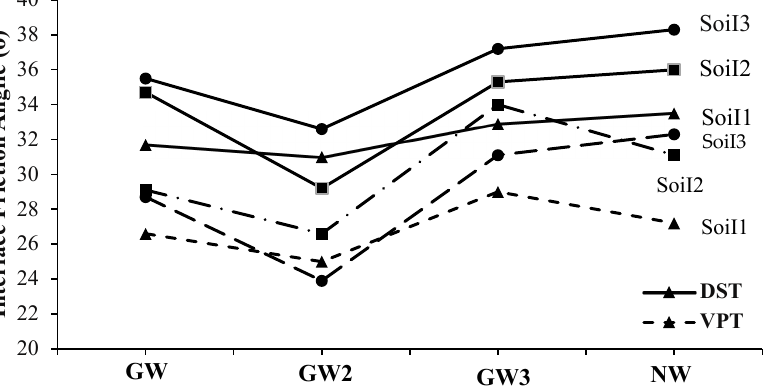
Figure 8. Comparison of interface friction angles obtained from modified direct shear tests and vertical pullout tests for various soil-geotextile interfaces.